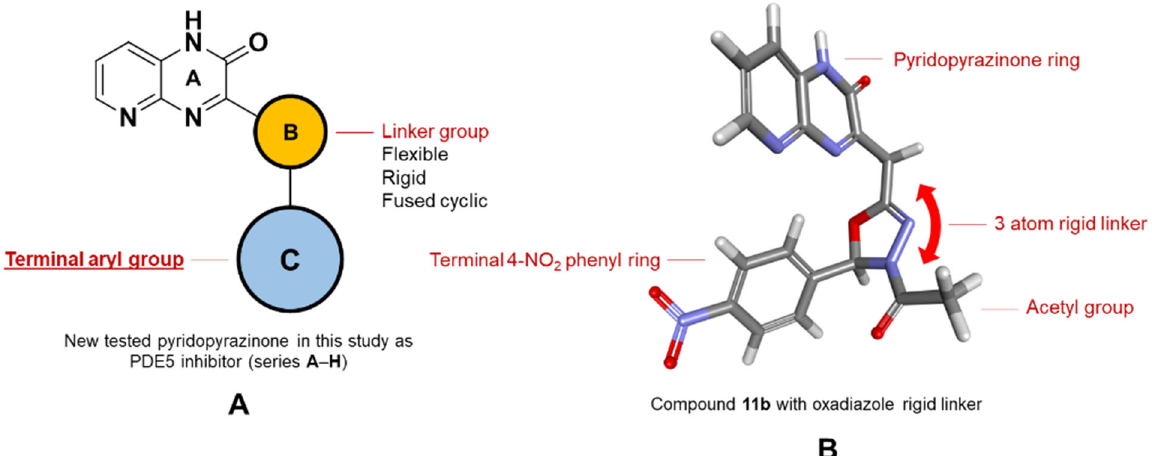
Figure 10. The proposed structure activity relationship (SAR) of the new pyridopyrazinone ‐ based derivatives (series A – H ) into PDE5 protein (PDB ID: 3HC8). ( A ) pyridopyrazinone ring favors to be anchored into the H pocket close to M ‐ loop and affords hydrophobic interactions as well as HB interaction. The central linker group acts as a hinge between the 2 binding motifs. The flexible spacer with optimum length (5 atoms) will allow this hinge to bring the 2 binding motifs inside the binding pocket. The rigid spacer with five ‐ membered ring is rigid enough to keep the angular orientation between the 2 binding motifs inside the active site. The fused cyclic spacer creates an unfavorable strain between the 2 binding motifs. The terminal aryl motif with HBD/HBA groups will enhance the binding through HB to Gln 817 in the Q pocket. Bulky aryl groups (series C ) will deteriorate the residence of the 2 binding motifs together into the active site. ( B ) the stable conformation of compound 11b inside PDE5 binding site. The oxadiazole rigid ring affords a stable hinge (3 atoms length) between the 2 binding motifs. The terminal NO 2 group affords a strong HB interaction with Gln 817 in Q pocket (2.69 Å). The acetyl substitution swims in the solvent-exposed